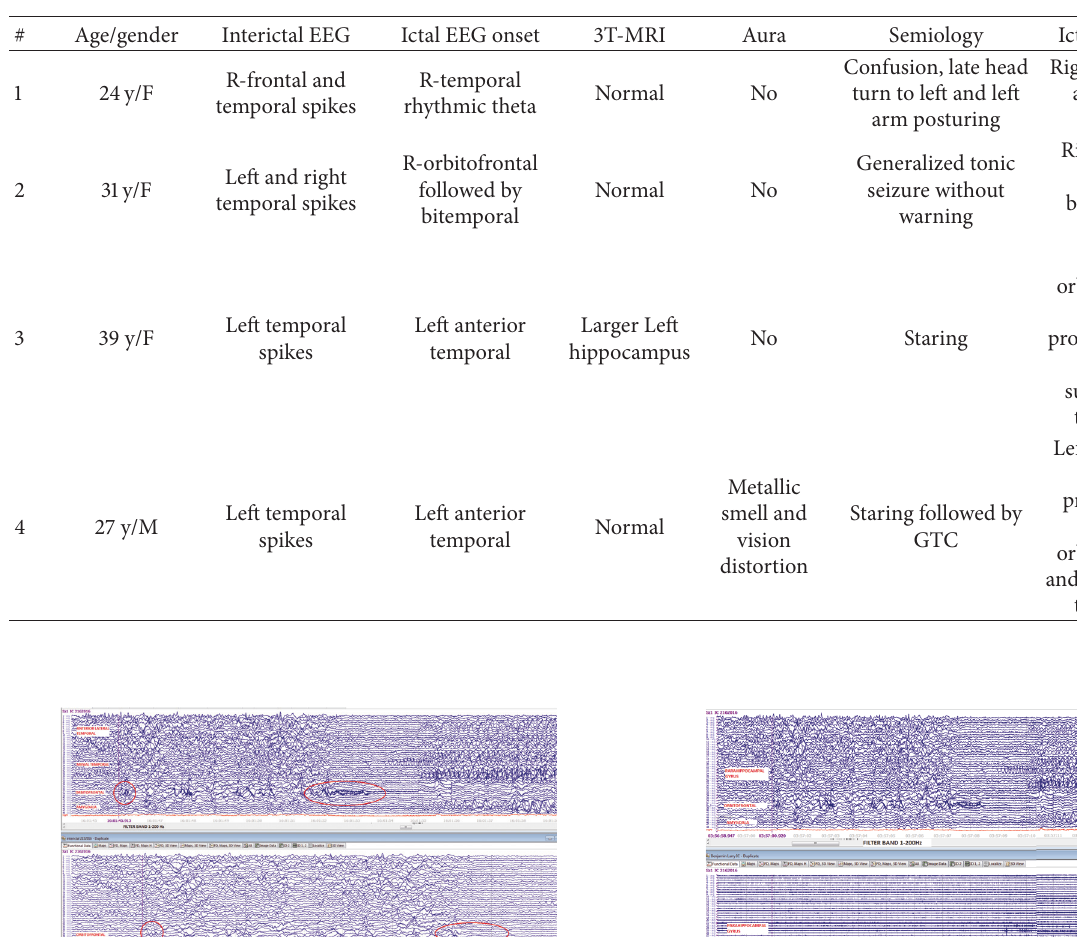
Table 1: Clinical features, imaging correlation, and ictal HFO data.